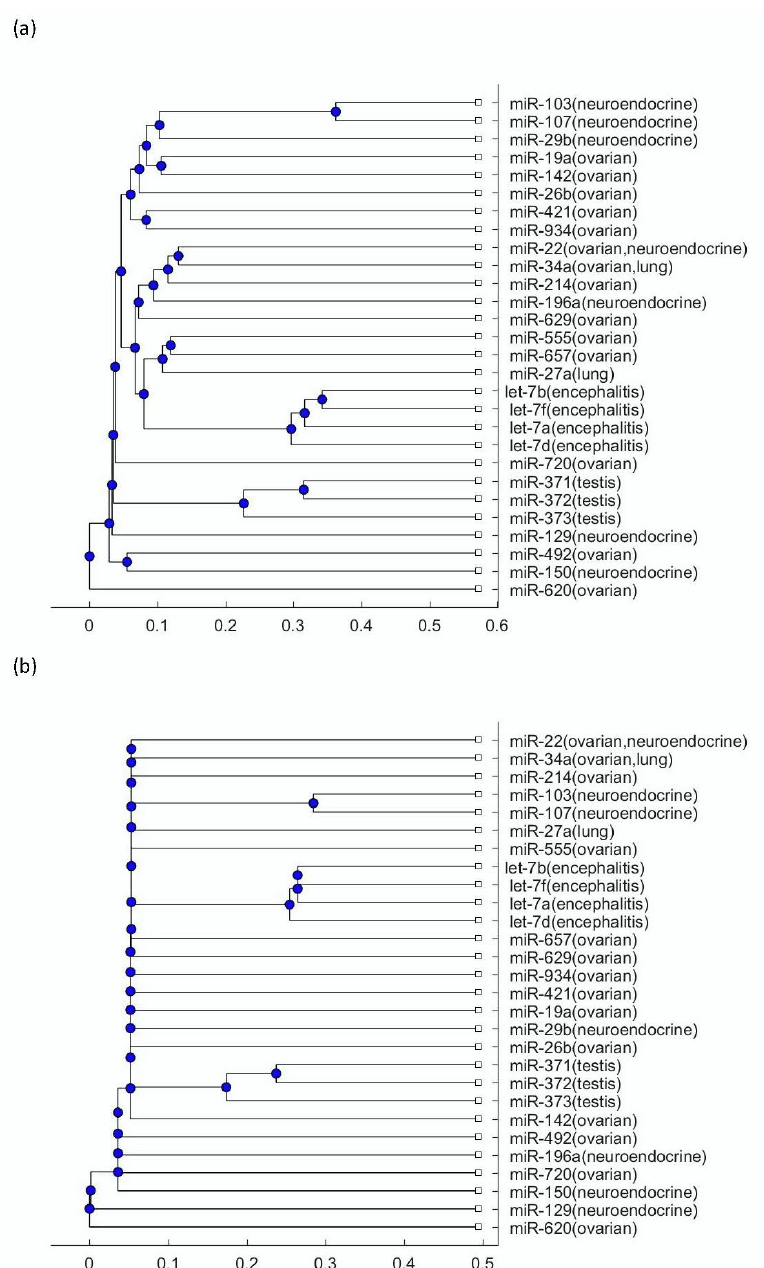
average method. ( b ) The phylogenetic tree of miRNAs shown in Table 1 based on the p distance and the median